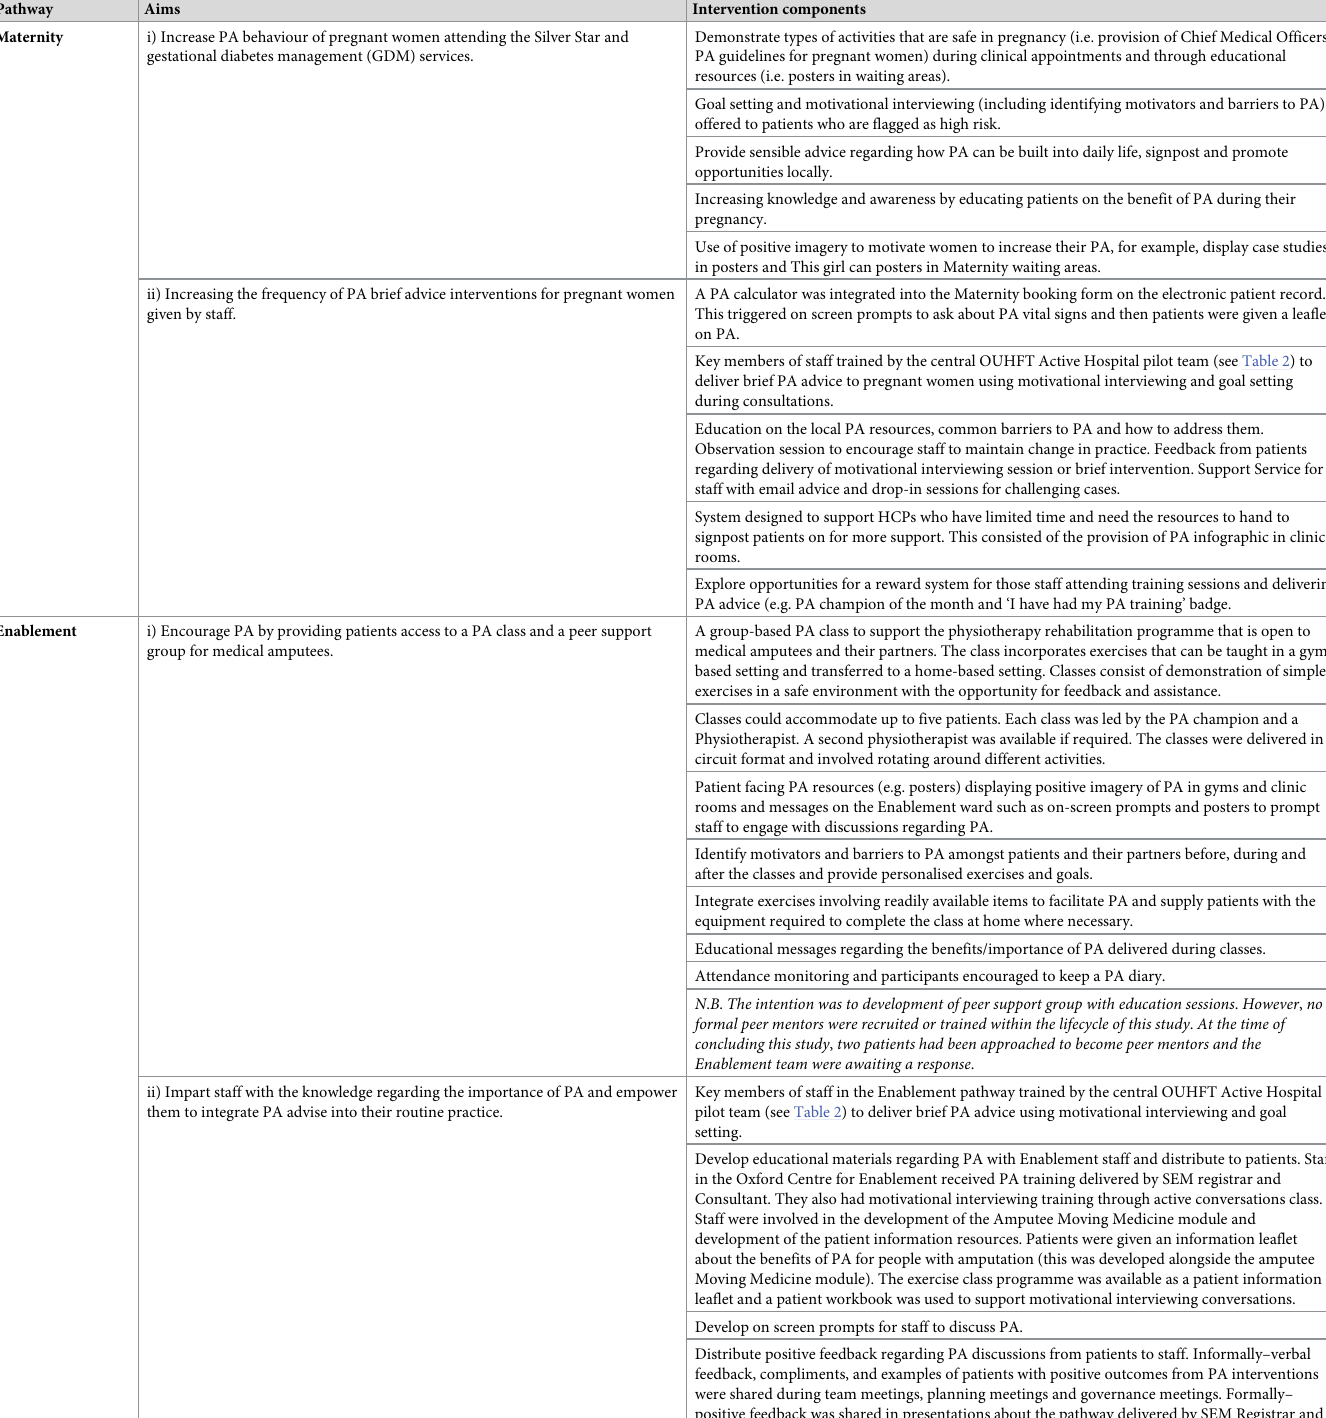
Table 1. Overview of the aims and intervention components for each of the four clinical pathways involved in the Active Hospital pilot at